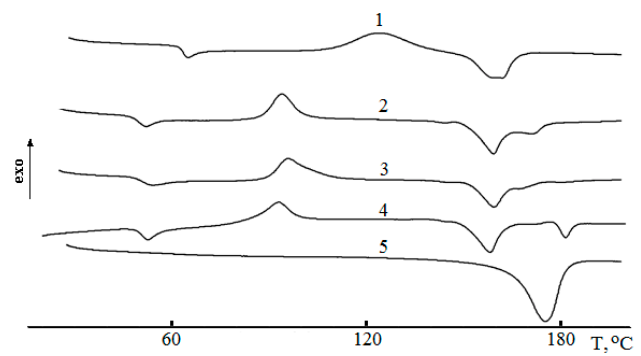
Figure 2. DSC curves of PLA (1), PHB (5) and PLA–PHB blends (80: 20 wt %) with 5 wt % PEG of different molar mass 400 (2), 600 (3), and 1000 (4). Table 1. Thermophysical characteristics of initial PLA and in its blends of various compositions at the first and second heating.